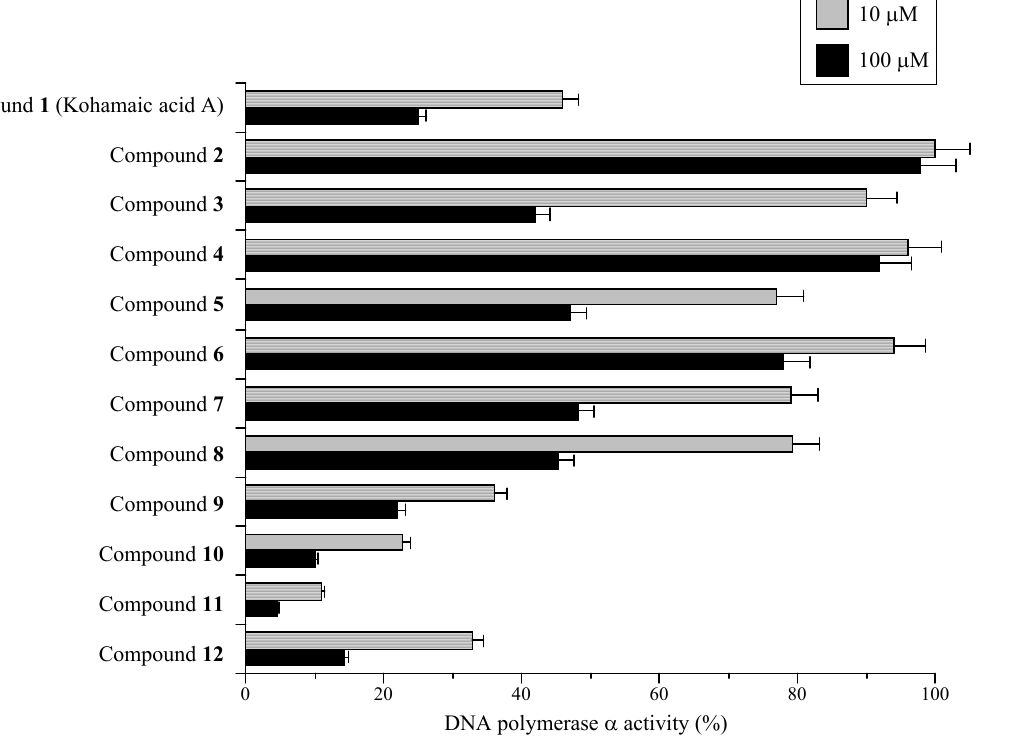
DNA polymerase α activity